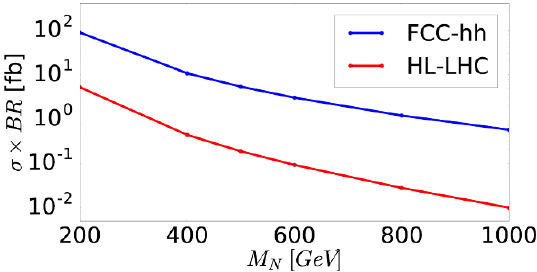
Figure 2 . Production cross section times branching ratio (cid:27) ( pp ! l (cid:6) N ) (cid:2) BR( N ! l (cid:7) jj ) in fb for heavy neutrino mass eigenstates via the Drell-Yan processes pp ! W (cid:3) ! ‘ (cid:6) N ! ‘ (cid:6) ‘ (cid:7) jj at leading order. Here, l = e; (cid:22) and the cross section includes di-leptons with all (cid:13)avor combinations (i.e., e (cid:6) (cid:22) (cid:7) , e + e (cid:0) , and (cid:22) + (cid:22) (cid:0) ). The active-sterile mixings are (cid:12)xed as j V lN j 2 = j V eN j 2 = j V (cid:22)N j 2 = 10 (cid:0) 2 , j V (cid:28)N j =